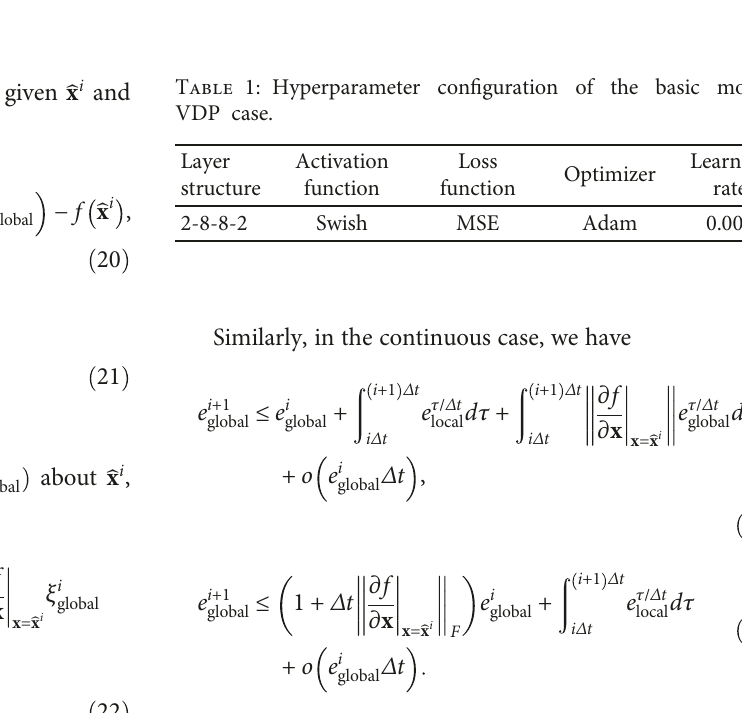
Figure 1: VDP case. (a) Distribution of training/testing sets. (b) Learning rate.